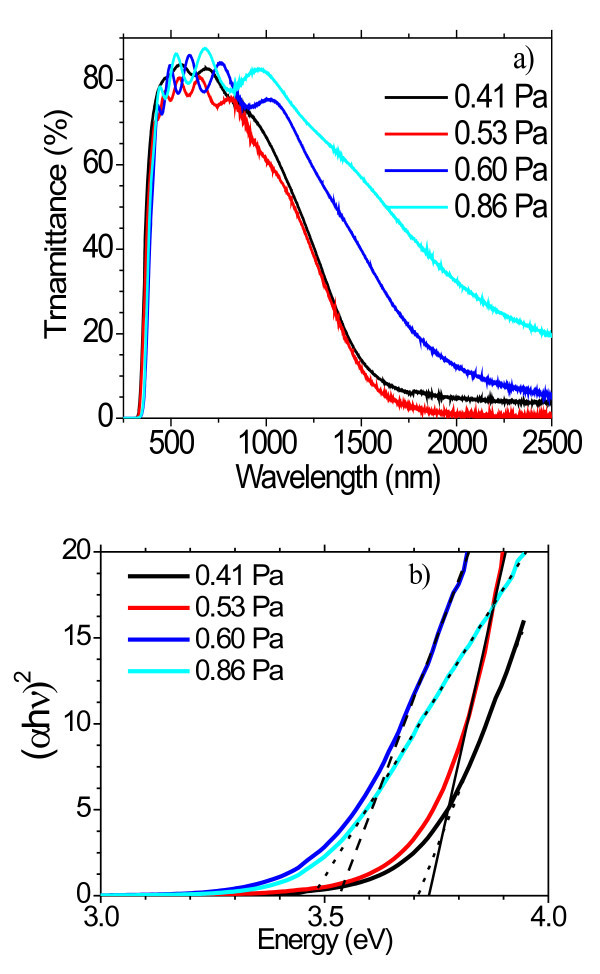
Optical transmittance of GZO/glass at various Pws.